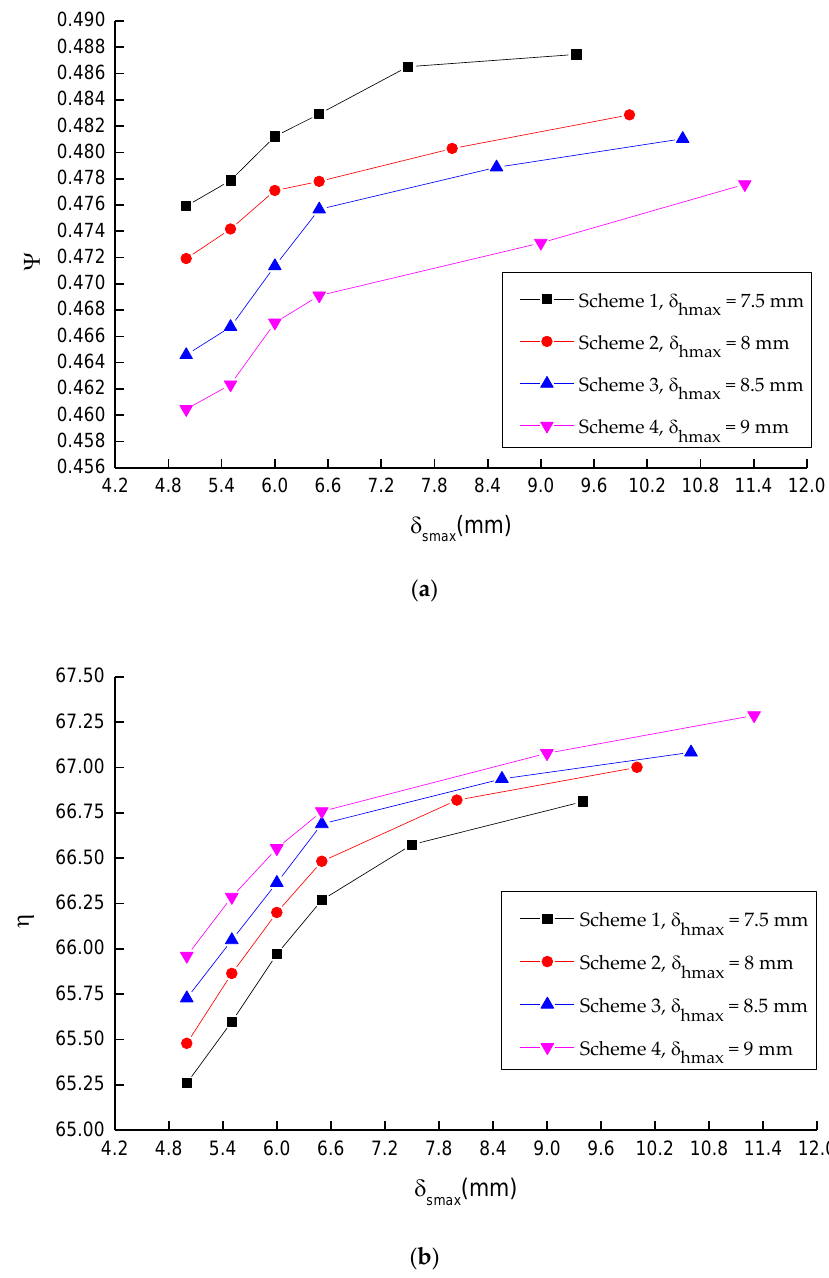
Figure 11. The relationship of the ( a ) head coefficient and ( b ) efficiency with different thickness schemes.